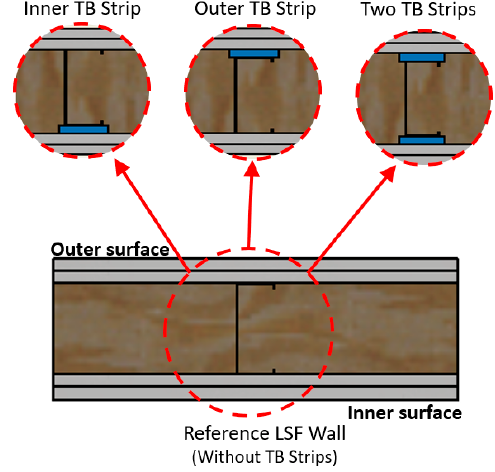
Table 2. Thermal conductivities ( λ ) of the thermal break strips.